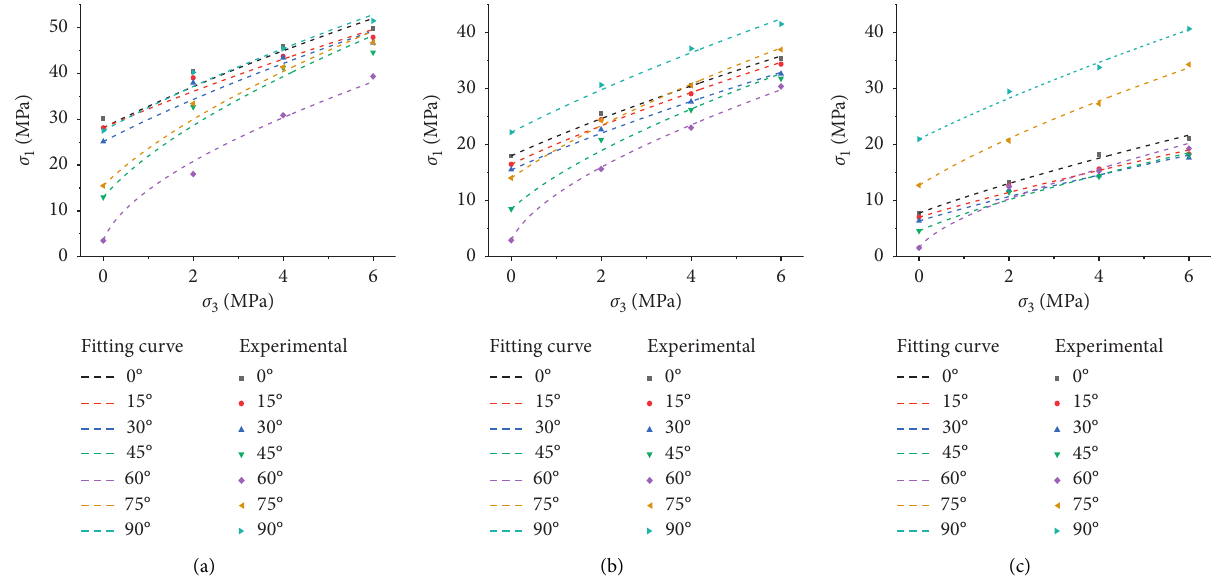
Figure 13: Fitting curve of the Hoek–Brown strength criterion. (a) Group AA, (b) Group AB, and (c) Group AC.